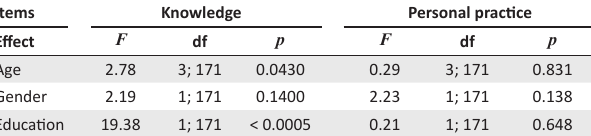
TABLE 5: Analysis of variance results – knowledge and practice personal by demographic variables ( n =